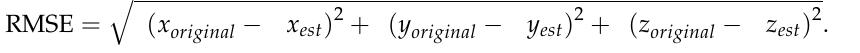
Table 6. Estimated coordinates of the PD source and the average errors of the PD localization. PD